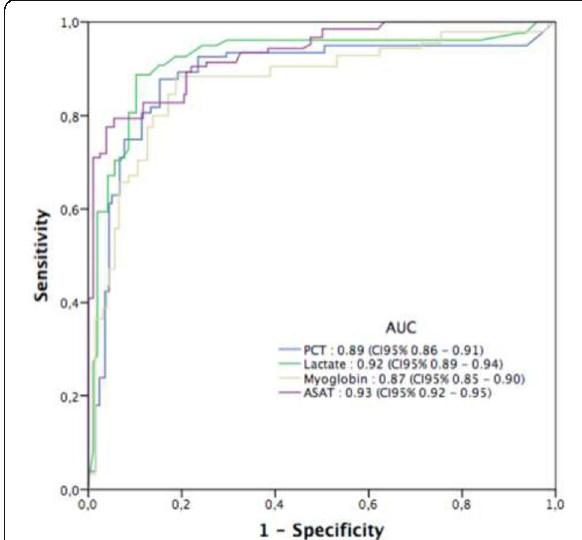
Fig. 1 (abstract 0091). Comparison of the ROC curves showing the Se and Sp of each marker (PCT, ASAT, last,